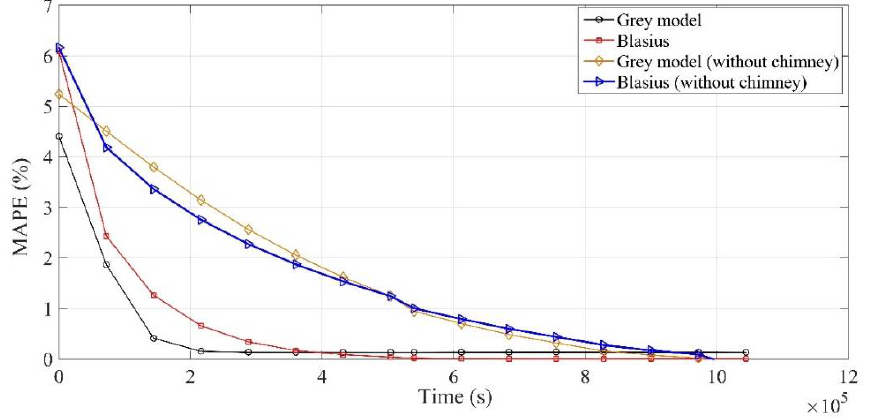
Figure 7. The change in mean absolute percentage error (MAPE) of the models while predicting the actual velocity of air.